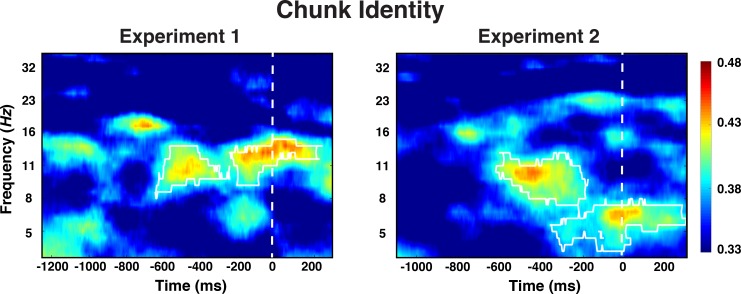
Experiment 1 and 2 decoding results as a function of frequency and time for chunk identity.The legend shows the decoding accuracy in probability. Chance level is p = 0.33. The regions enclosed by white lines show significant decoding accuracy after cluster correction.